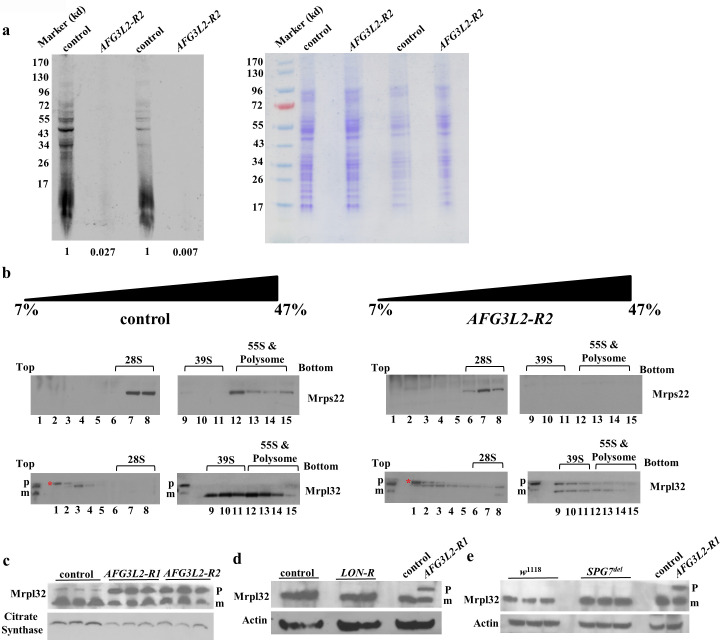
Afg3l2 deficiency impairs mitochondrial ribosome assembly and translation.a. Mitochondria from control (UAS-LUCIFERASE RNAi/da-Gal4) and AFG3L2-deficient (UAS-AFG3L2-R2 RNAi/da-Gal4) pupae were labeled with 35S-methionine for 1 h, then homogenized and subjected to SDS-PAGE. The left panel shows the 35S-labeled proteins, while the right panel shows the Coomassie staining pattern using the same samples. The Coomassie-stained samples were used to normalize protein loading (control samples defined as 1.0). b. Sucrose density gradient centrifugation was performed using mitochondrial protein extract from control (UAS-LUCIFERASE RNAi/da-Gal4) and AFG3L2-deficient (UAS-AFG3L2-R2 RNAi/da-Gal4) animals and fractions were subjected to immunoblotting using antisera against Mrps22 and Mrpl32. Red asterisks denote a non-specific band. c. Mrpl32 processing was analyzed by subjecting a mitochondrial protein extract from control (UAS-LUCIFERASE RNAi/da-Gal4) and AFG3L2-deficient (UAS-AFG3L2-R1 RNAi; da-Gal4 or UAS-AFG3L2-R2 RNAi/da-Gal4) pupae to western blot analysis using an antiserum against Mrpl32. Citrate synthase was used as a loading control. The ‘p’ and ‘m’ denote the pre-sequence containing form of Mrpl32 and the mature form of Mrpl32 lacking the presequence, respectively. d. Mrpl32 processing was analyzed as in (c) using protein extracts from control (UAS-LUCIFERASE RNAi/da-Gal4) and LON-deficient (UAS-LON-R RNAi/da-Gal4) pupae. e. Mrpl32 processing was assessed as in (c) and (d) using protein extracts from control (w1118) and SPG7del flies. A cell lysate from AFG3L2-deficient (UAS-AFG3L2-R1 RNAi; da-Gal4) pupae is shown in (d) and (e) to illustrate the locations of the pre-sequence containing form of Mrpl32 (P) and the mature form of Mrpl32 lacking the presequence (M). Actin was used as a loading control in (d) and (e).